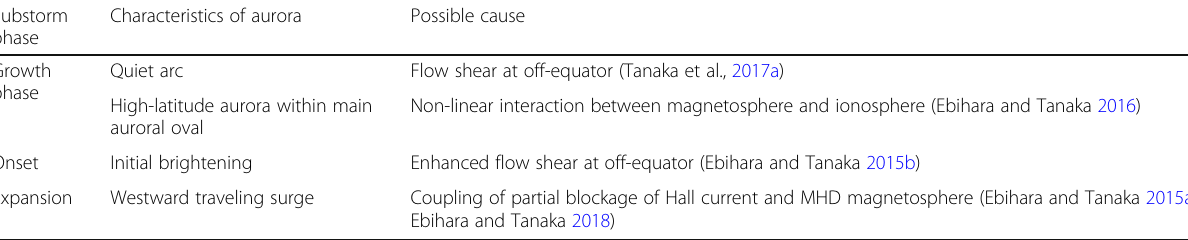
Table 1 Cause and effect relationship for substorm-associated aurora as suggested by the global MHD simulation